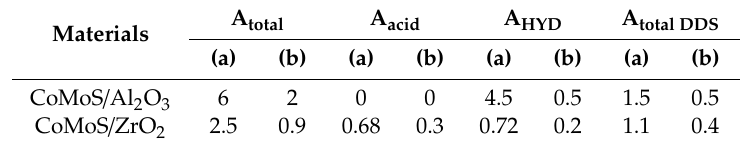
Table 4. The 46DMDBT HDS activities (A): (a: (mmol.h − 1 .m − 2 ). 10 − 3 ); (b (mmol.h − 1 .Mo atom − 1 ).10 − 21 ) for CoMoS / Al 2 O 3 and CoMoS / ZrO 2 materials (T = 340 ◦ C, P = 40 bars, H 2 / feed = 475 NL /